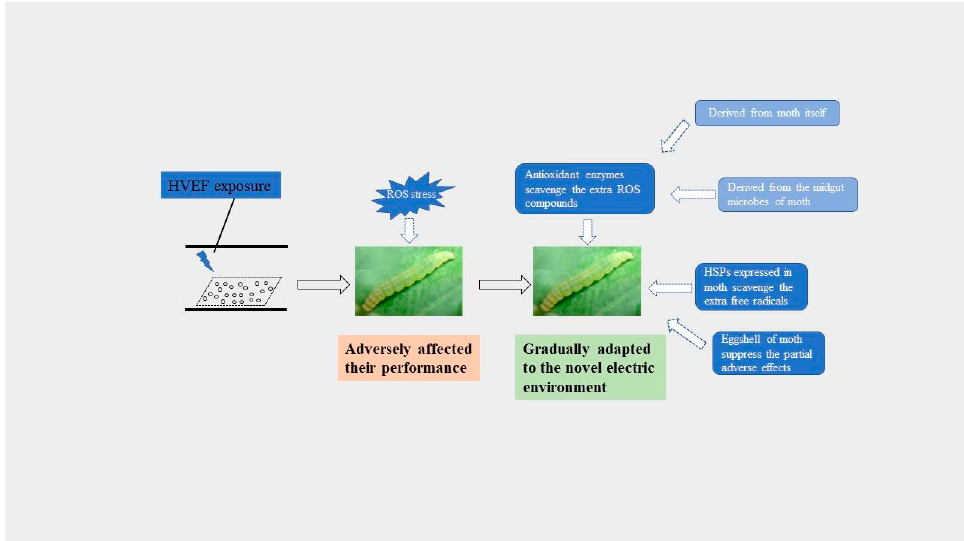
Figure 7. Proposed alterations in P. xylostella after exposure to HVEF stress based on findings obtained in or deduced from this study. Solid arrows represent pathways supported by experimental evidence from the present study; dotted arrows represent potential physiological alterations predicted from the literature.